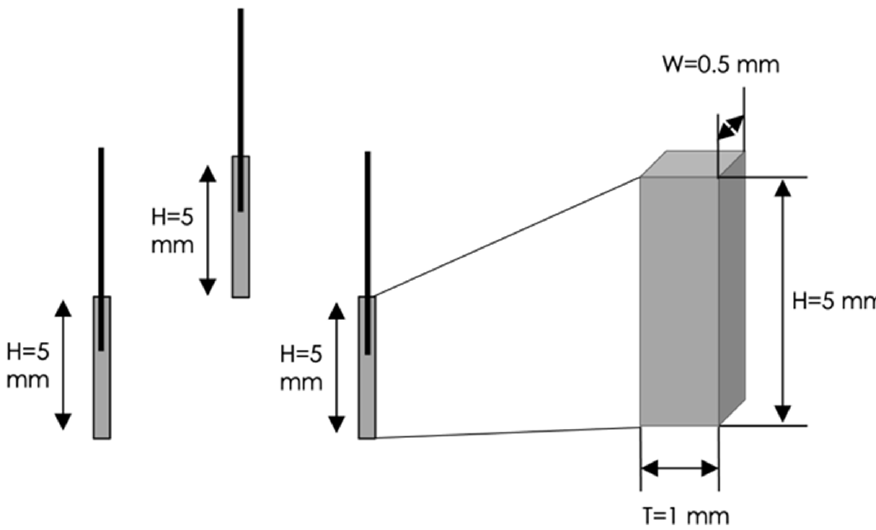
Figure 2. Geometric dimensions of the three electrodes embedded in the Prototype 1.